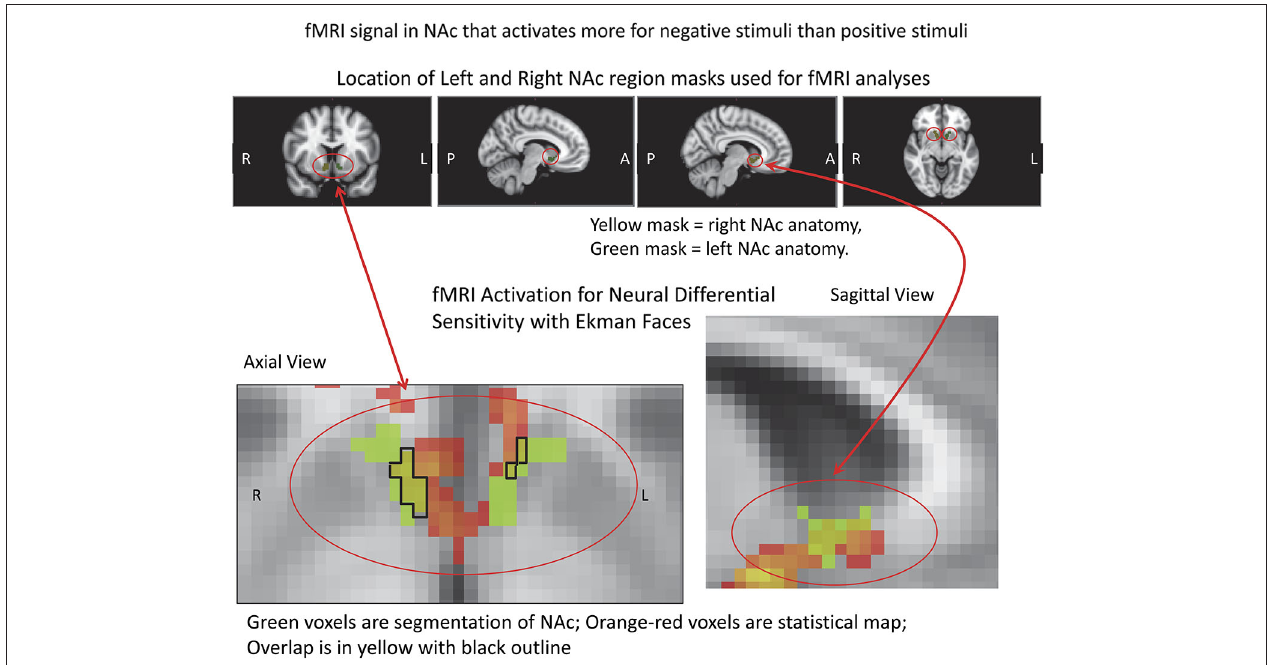
in light green in the images below, superimposed on the gray-tone ICBM152 T1 template. The light green segmentations are overlaid with the orange-red statistical map for NDS. Overlap of segmented anatomy and statistical activation map is outlined in black, with yellow inside the closed